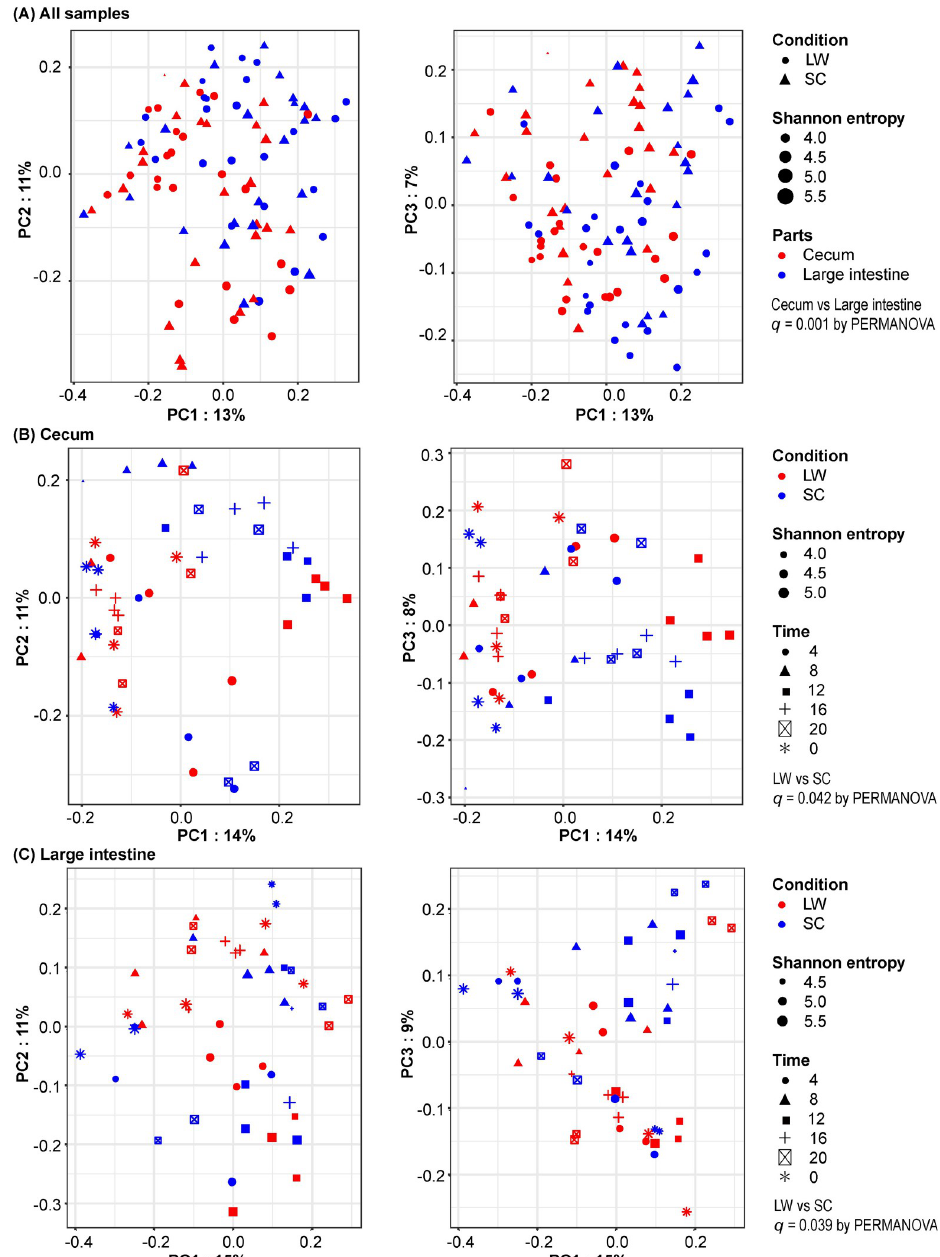
Fig 1. Differences in the microbiome under summer- and winter-mimicking conditions. Principal coordinate analysis (PCoA) plot with Bray Curtis distance in the gut microbiome of CBA/N mice. (A) PCoA plot using all samples of long day and warm (LW) and short day and cool (SC) groups. Each point represents one sample. The shape of the dot represents the seasonal conditions. The size of the dot represents Shannon diversity, and the color of the dot represents the intestinal sites (Cecum, Large intestine). (B and C) PCoA plots in the cecum (B), and the large intestine (C). The color of the dots indicates the seasonal conditions (LW, SC). The size of the dots indicates the Shannon diversity, and the shape of the dots indicates the sampling time (0:00, 4:00, 8:00, 12:00, 16:00, 20:00). The number of individuals at each sampling time was 4. However, the number was 2 at two points (cecum LW 8:00 and large intestine SC 16:00) because some samples failed in the quality control